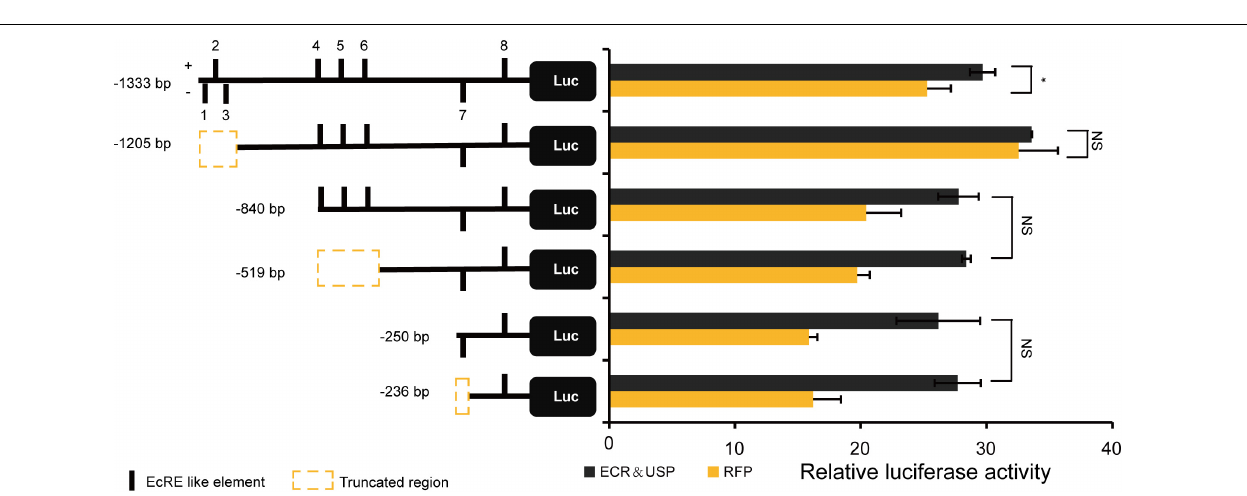
FIGURE 2 | Effect of 20-hydroxyecdysone (20E) on Bombyx mori ERR ( BmERR ) promoter activity. (A) Comparison of transcriptional activity between the BmERR promoter and control pGL3-basic plasmids. The luciferase activity was corrected for transfection efficiency with the Renilla luciferase pRL-78ML plasmid and is presented as ratios to the activity of the BmERR promoter. (B,B’) Changes of BmERR promoter activity with different concentrations of 20E. (C) Quantitative real time-PCR (qRT-PCR) detection of BmERR expression in BmE cells treated with 10 nM 20E. Dimethyl sulfoxide was used as the control treatment. * P < 0.05, *** P < 0.001, and t -test.